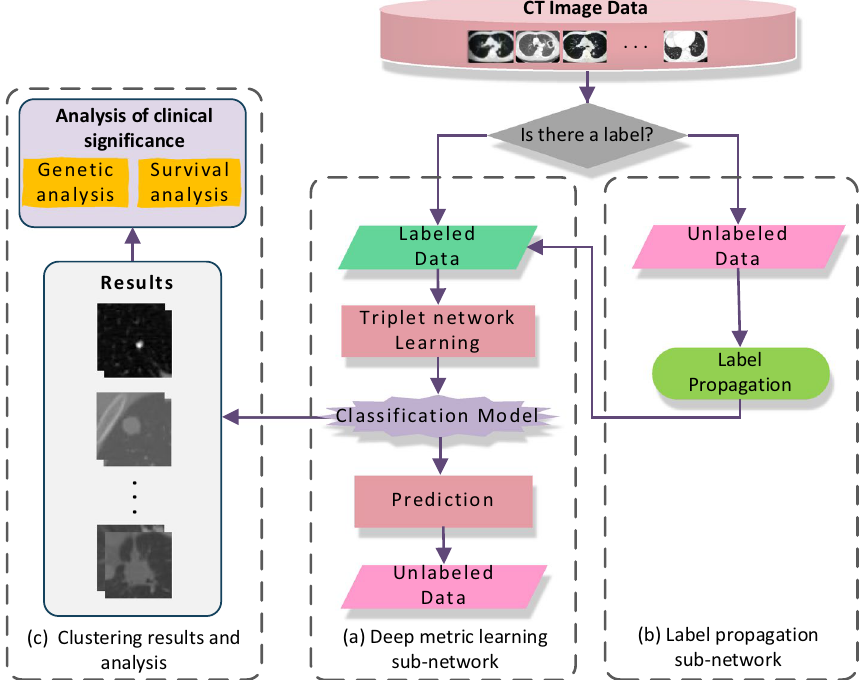
Figure 4. Block diagram of the proposed of lung cancer imaging subtype classification based on label propagation model ( a ) Deep metric learning sub-network ( b ) Label propagation sub-network ( c ) Clustering results and